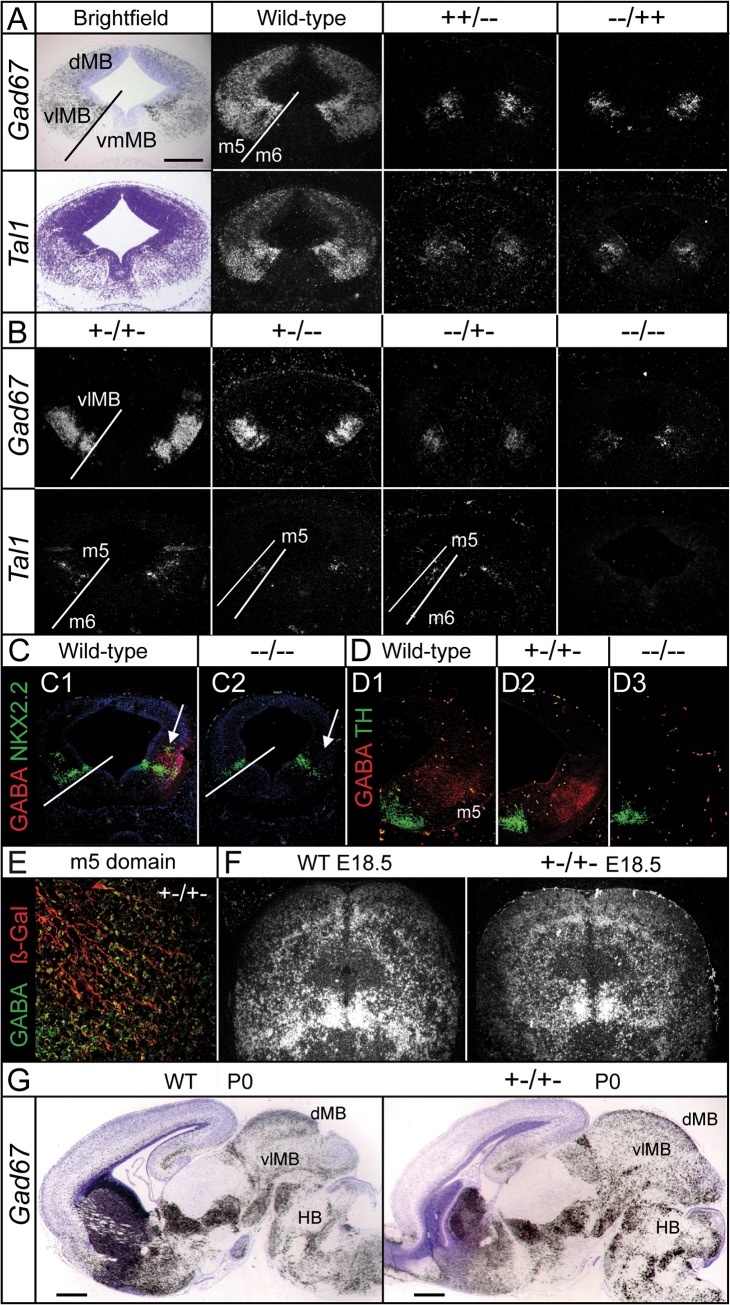
MB GABAergic pathway was severely compromised in the double and compound mutants.Expression of GABAergic-specific genes on the coronal sections of E12.5 in wild-type and single knockout embryos (A), as well as in compound and double knockout mutants (B). MB GABAergic induction occurred in double heterozygous mice based on the presence of GABAergic markers (Gad67 and Tal1). (A-E) The GABA phenotype observed at E12.5 in the vlMB of Mgn
−/−
Mash1
−/− (−−/−−) mice (C2 and D3) was recovered in Mgn
+/−
Mash1
+/− mice (D2 and E). The intermediate zone of m3 domain is magnified in E. GABAn of double heterozygous embryos were maintained at E18.5 (F) and until postnatal death P0 (G). DAPI, NKX2-2, TH, and β-Gal staining were used as morphological markers). Arrows indicate the loss of postmitotic NKX2-2 neuronal subpopulation in the m2 domain, but not in the m4 domain (C). Scale bars: 500 μm in A and G, and 50 μm in E.